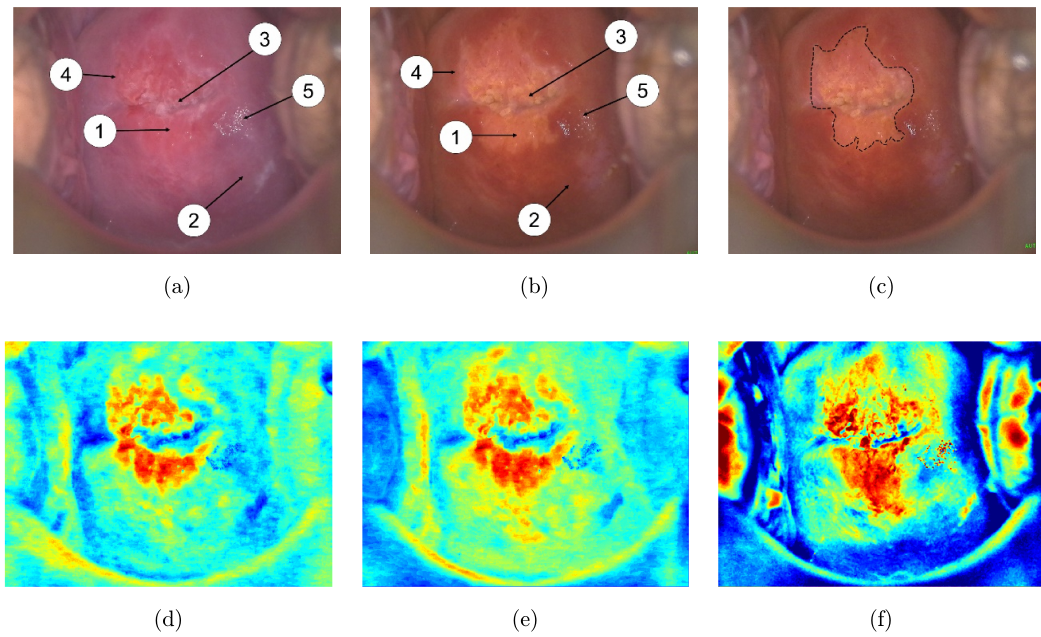
Fig. 5. In vivo cross-polarized RGB pictures of cervical ectopy: (a) Image before applying Lugol's iodine, (b) Image after applying Lugol's iodine, (c) SCJ is characterized dotted black lines, ( d) Blood 1 Contrast, (e) Blood 2 Contrast, (f) Collagen Contrast, in which hottest color: columnar area (color map: jet). In which: (1) Columnar epithelium, (2) Squamous epithelium, (3) Cervical canal, (4) SCJ and (5)